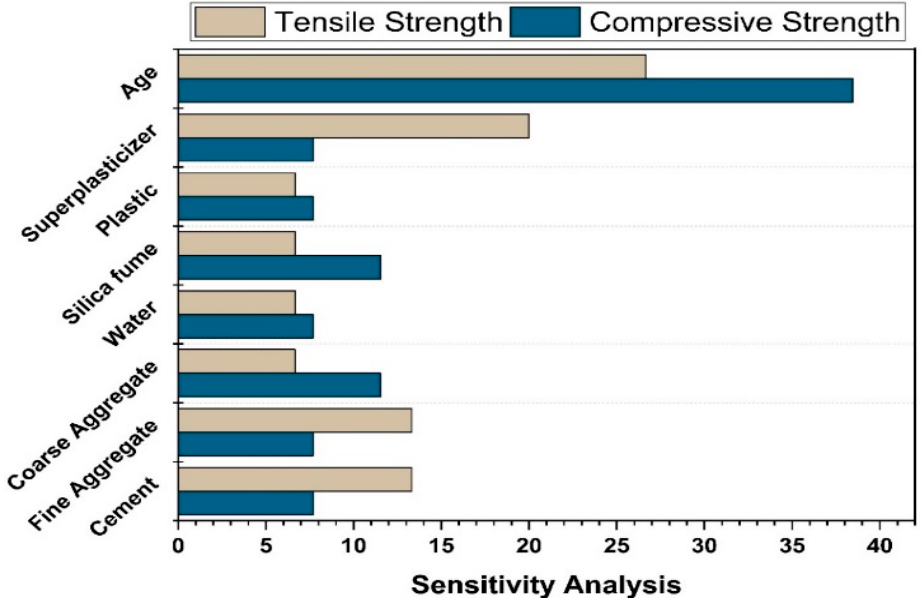
Figure 22. Input parameters’ contribution to compressive and tensile strength models.